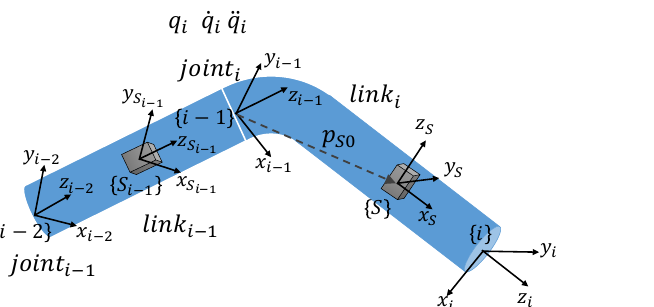
Figure 6. Schematic diagram of the nonlinear relationship between accelerometer output and angular